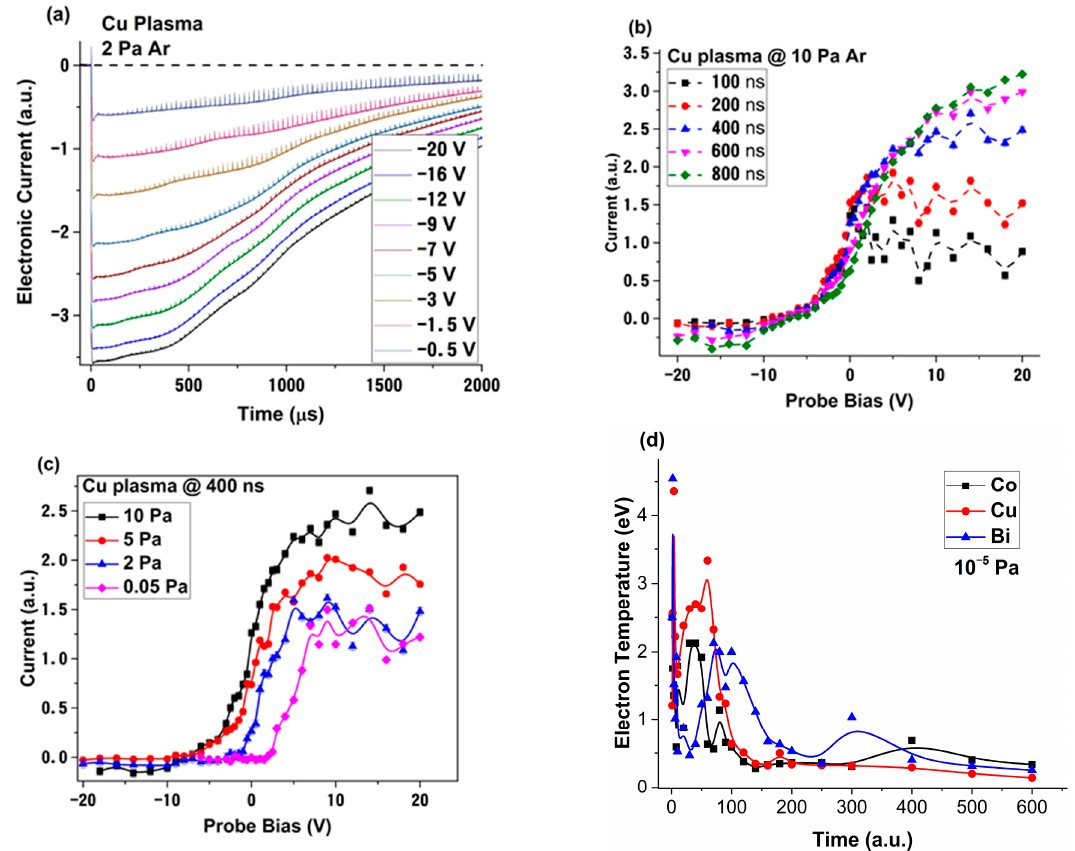
Figure 1. Selected signals from Cu plasma in 2 Pa of Ar ( a ), the IV characteristic of Cu plasma at various 10 Pa of Ar ( b ) and various moments in time ( c ), as well as the electron temporal evolution for Co, Cu and Bi plasmas ( d ) (lines are guides for the eyes).